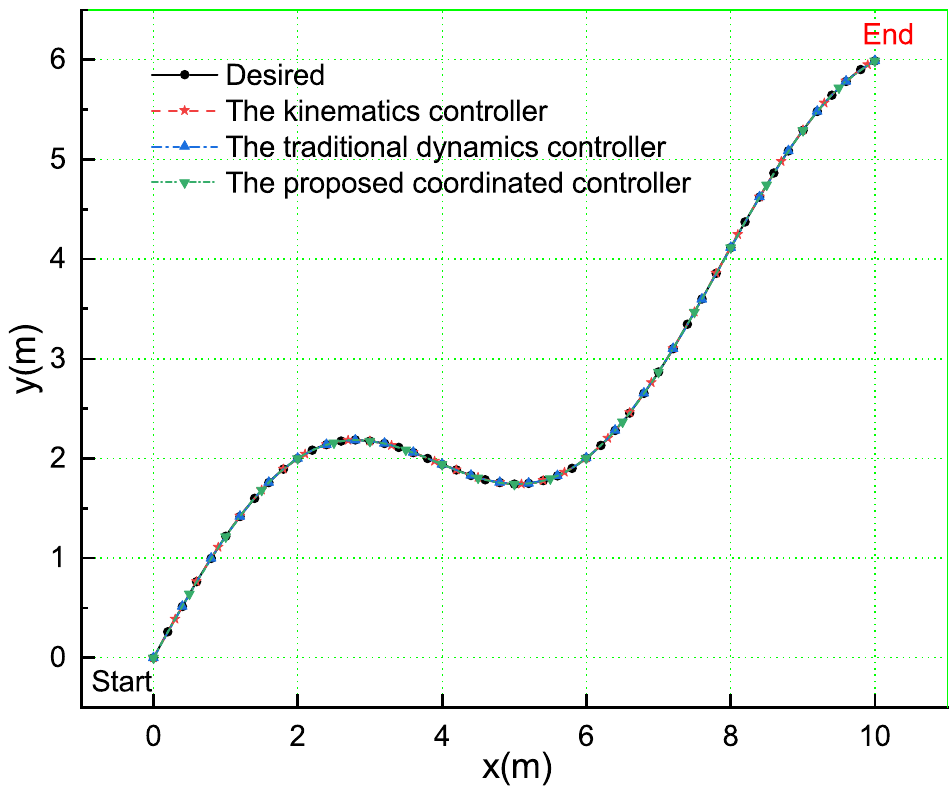
Figure 7. The simulation results for the S type trajectory tracking